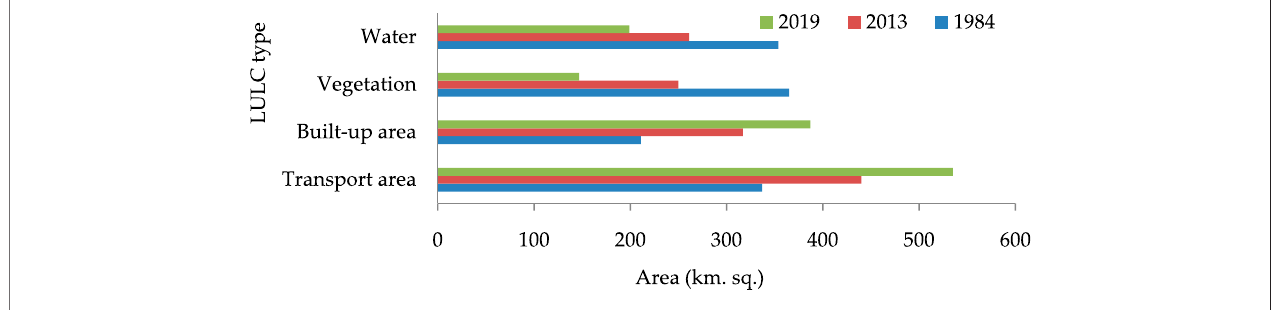
FIGURE 4 | Spatial-temporal changes of LULC classes from 1984 to 2019.